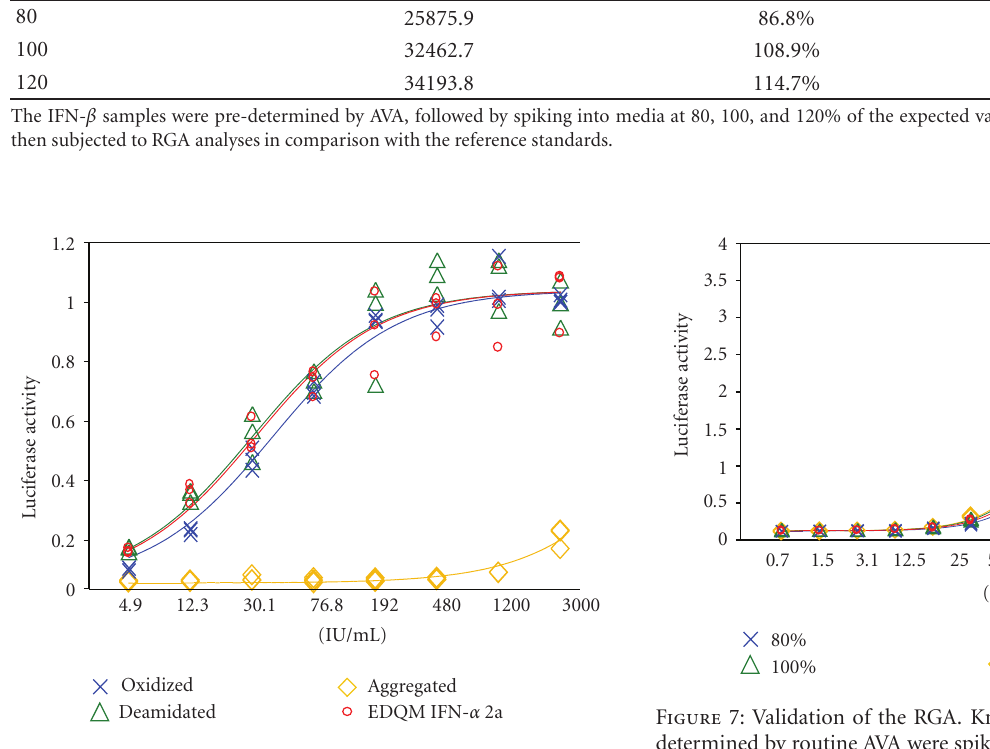
Figure 6: Analyses of IFN variants. The variants (IFN- α 2a) were prepared as described in [27] and (Diress et al. unpublished data). The variants included aggregated, deamidated or oxidized forms. The data showed that no significant loss of potency was observed with deamidated IFN while approximately 23% loss of potency was observed with the oxidized form; moreover, the aggregated form completely lost its bioactivity. Each sample was tested in triplicate and potency was determined by comparisonto the EDQM IFN- α 2a reference standard.